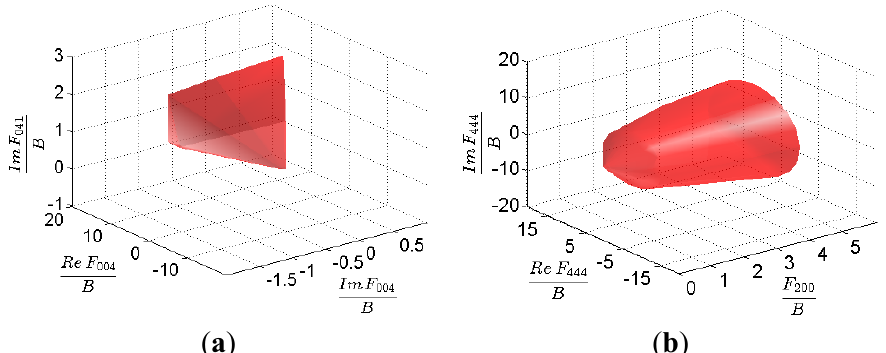
, ImF , ImF 004 004 041